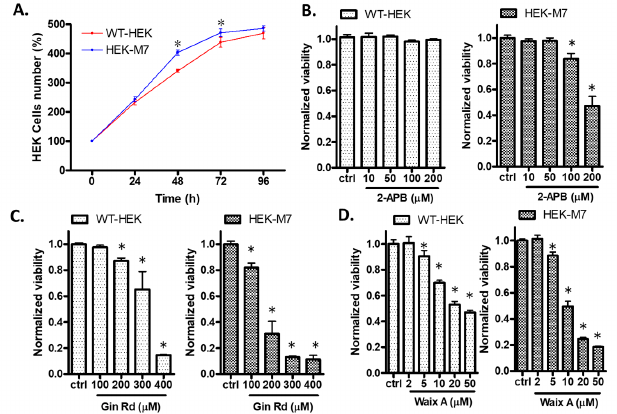
Figure 1. Effect of transient receptor potential melastatin 7 (TRPM7) inhibitors on wildtype human embryonic kidney HEK293 (WT-HEK) and human embryonic kidney HEK293 overexpressing TRPM7 (HEK-M7) cell viability. ( A ) WT-HEK and HEK-M7 cells proliferated similarly at 24. There was a significant difference in the number of cells at 48 and 72 h, but not 96 h. ( B – D ) The effect of the TRPM7 inhibitors 2-aminoethyl diphenylborinate (2-APB), ginsenoside Rd (Gin Rd), and waixenicin A (Waix A) on WT-HEK and HEK-M7 viability tested using MTT assay. All three inhibitors tested